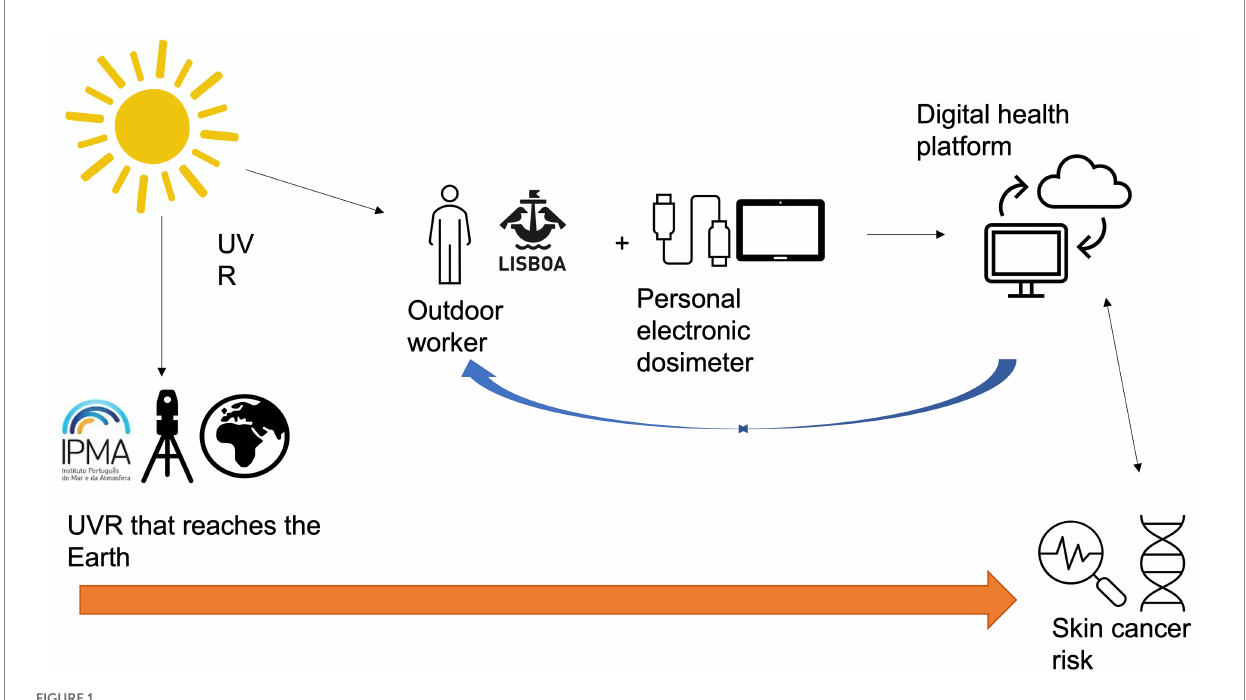
FIGURE 1 Conceptual map of the study